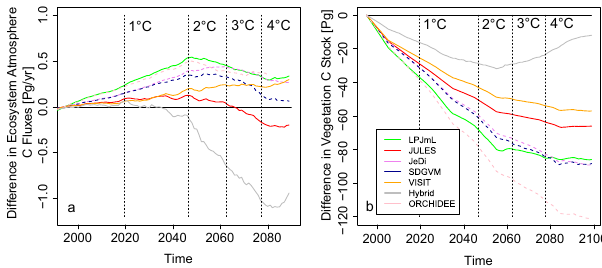
Figure 4. (a) Loss of carbon sinks (ecosystem–atmosphere C flux) due to reduction of natural vegetation and (b) associated changes in the vegetation C stock (Cveg). Coloured lines repre- sent 20-year running means of the differences of these variables between the LU change scenario and the reference scenario (fixed 1995 area of natural vegetation). Positive values indicate higher ecosystem–atmosphere C fluxes and a reduction in Cveg under LU change. Colour coding indicates the different bio-geochemical models. Solid (dashed) lines represent simulations based on dy- namic (static) vegetation patterns. Results are based on the historical and RCP8.5 simulations by HadGEM2-ES. Dashed vertical lines: years where the global mean temperature change with respect to 1980–2010 reaches 1, 2, 3, and 4 ◦